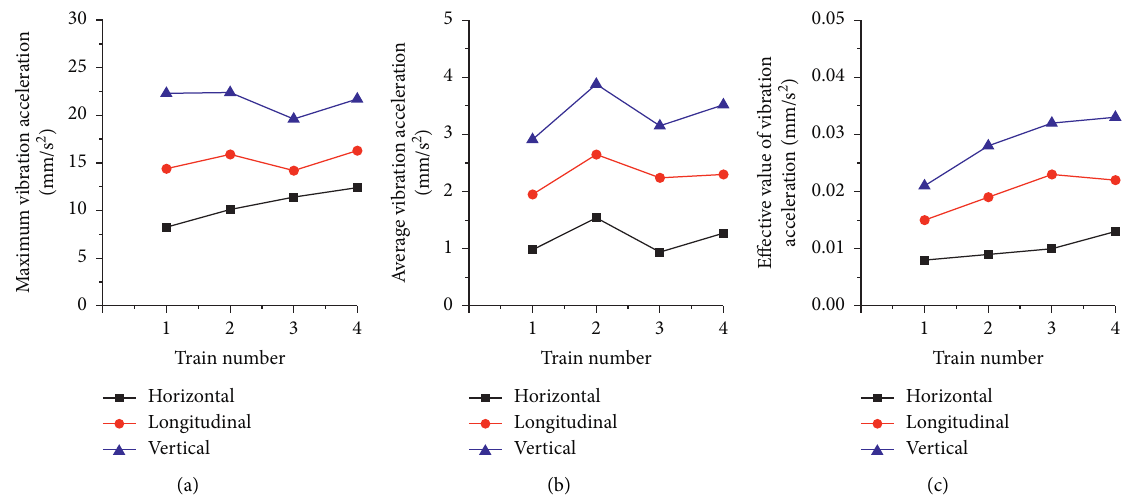
Figure 7: Vertical vibration acceleration at K329+530 C1 measuring point. (a) Maximum before reinforcement. (b) Average acceleration before reinforcement. (c) Effective value before reinforcement.